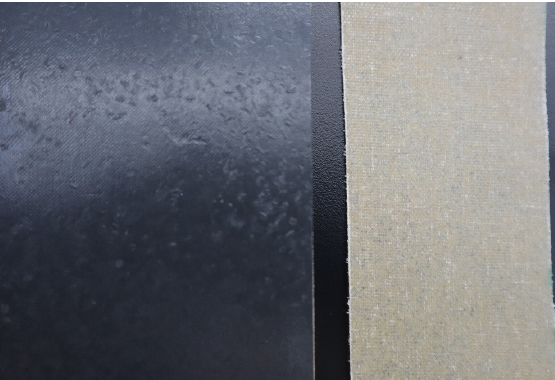
Figure 1. Pictures of the ABS ( left ) and GF prepreg ( right ) sheets used to manufacture distinct sandwich composite panels.